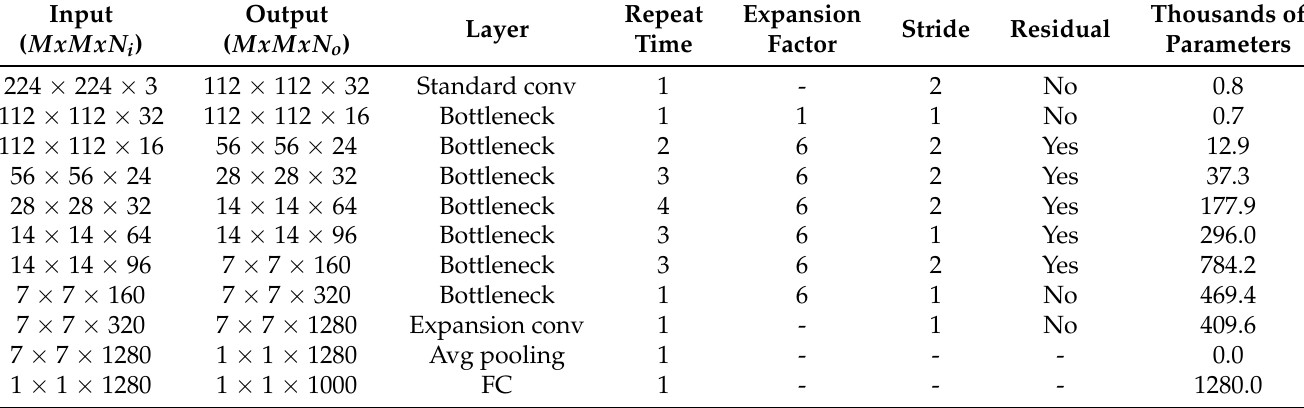
Table 2. MobileNet V2